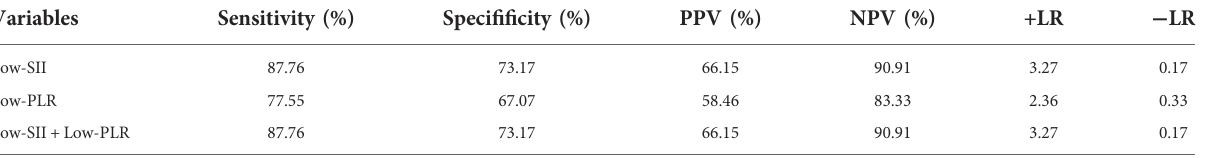
TABLE 5 Predictive value of Low-SII and Low-PLR for surgery.